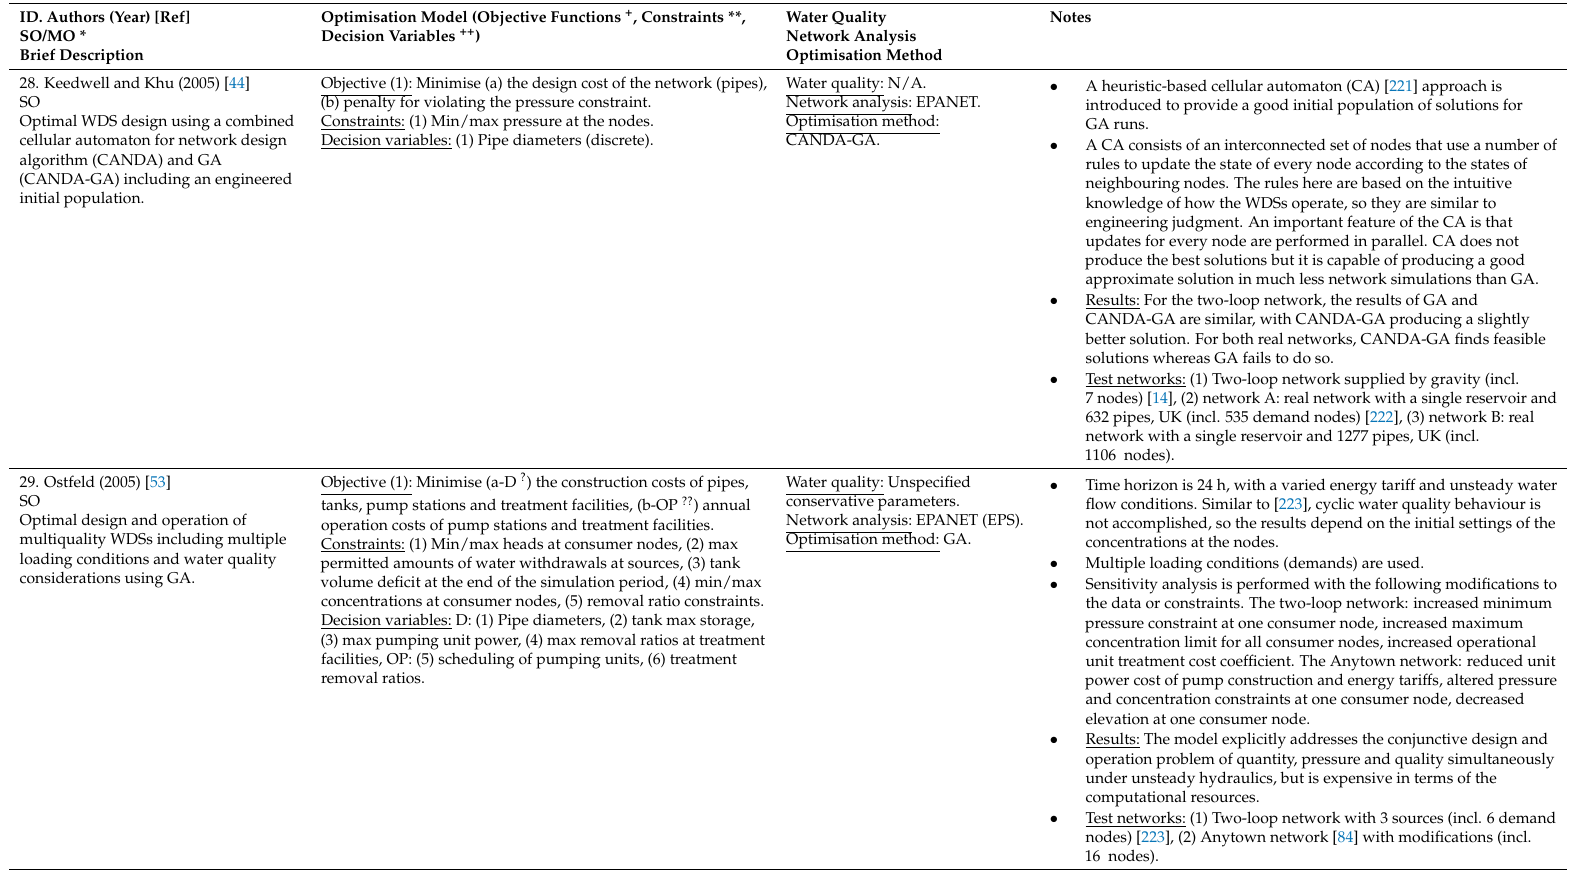
28. Keedwell and Khu (2005) [44] SO Optimal WDS design using a combined cellular automaton for network design algorithm (CANDA) and GA (CANDA-GA) including an engineered initial population.